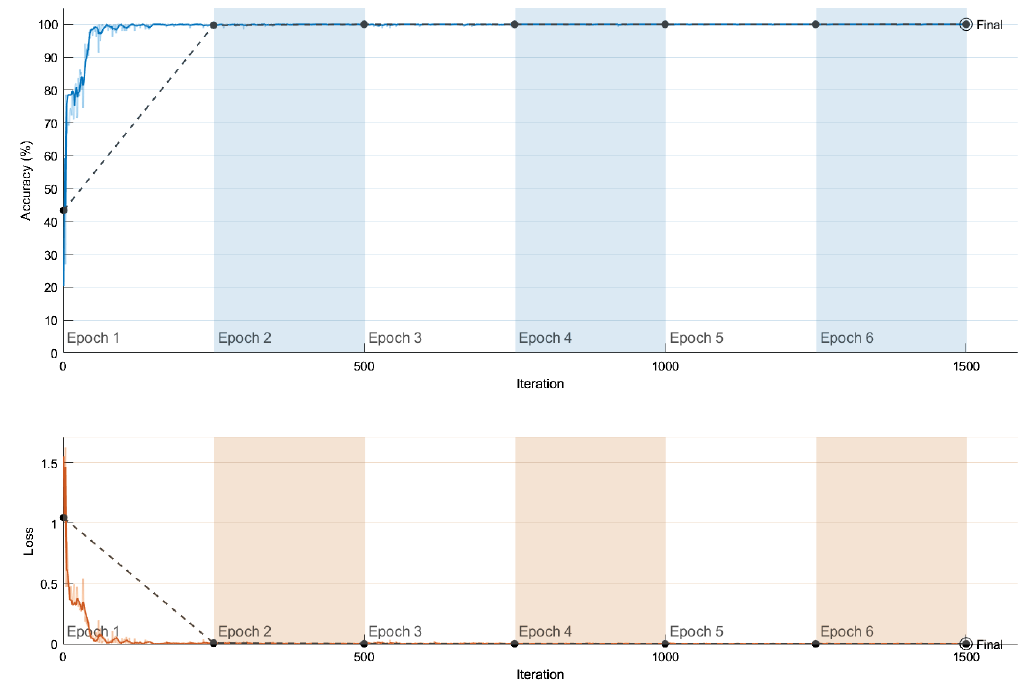
Figure 9. Training progress with accuracy and loss results.